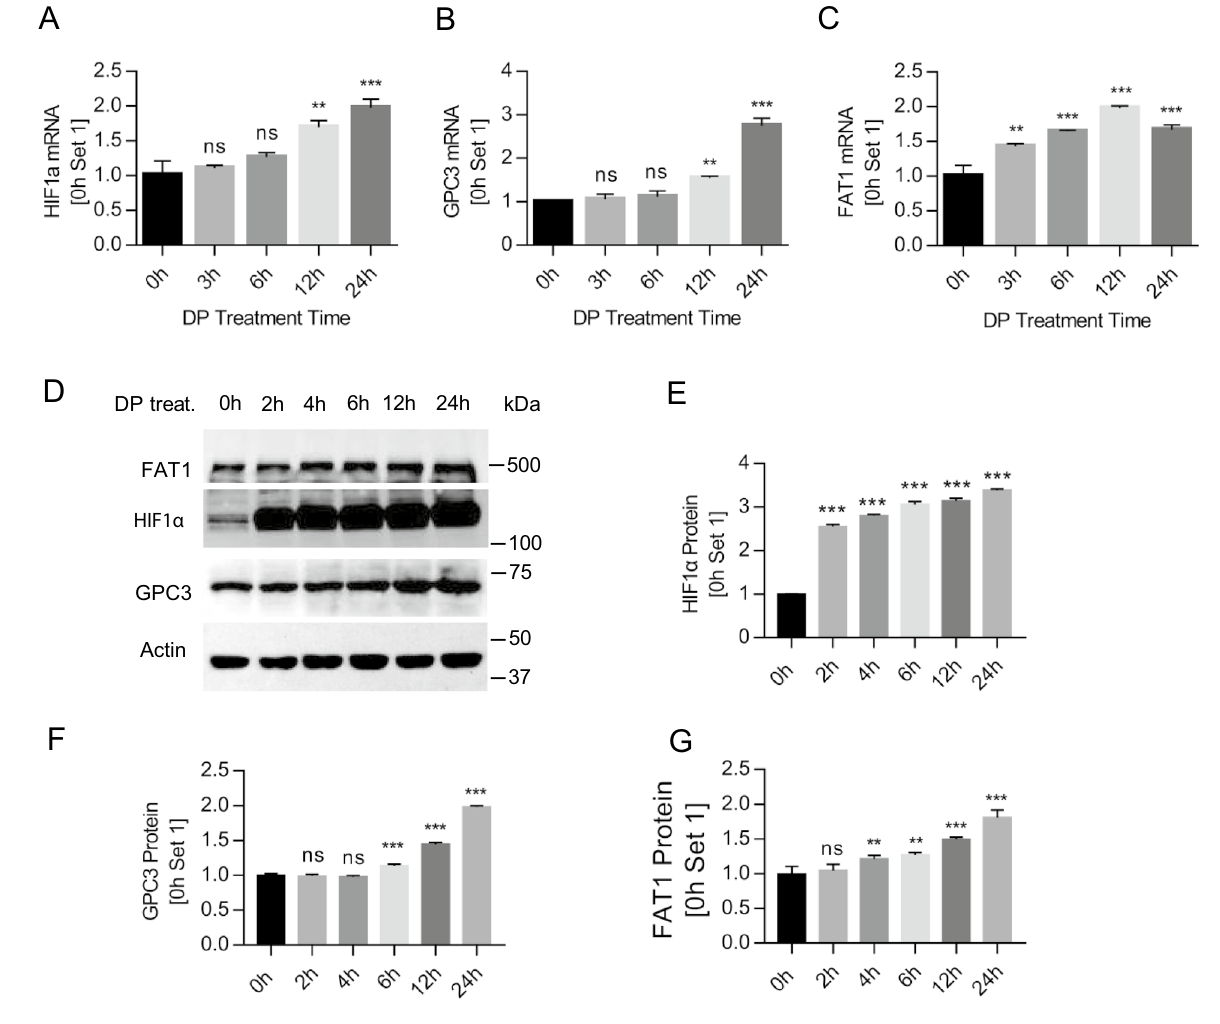
Figure 4. Up-regulated expression of HIF1α, GPC3, and FAT1 under hypoxia. ( A ) HIF1α mRNA level in HepG2 cells after DP (100 µM) treatment for different lengths of time. ( B ) GPC3 and ( C ) FAT1 mRNA levels after same treatment as ( A ). ( D ) Western blot analysis of HIF1α, GPC3, and FAT1 protein levels in HepG2 cells after DP (100 µM) treatment. Full-length blots/gels were presented in Supplementary Figure S4. Quantification was performed based on the band intensity and presented in ( E ) HIF1α, ( F ) GPC3, and ( G ) FAT1. Data represent mean ± SEM (n = 3). ** P < 0.01; *** P < 0.001. ns, not the expression pattern of GPC3 and FAT1 under hypoxia conditions, we treated HepG2 cells with chemical hypoxia inducer 2,2-dipyridyl (DP) as previously described 53 . As shown in Fig. 4, DP treatment significantly up- regulated the expression of HIF1α, GPC3, and FAT1 at both mRNA (Fig. 4A–C) and protein level (Fig. 4D–G). HIF1α protein level responded quickly to hypoxia induction, with an abrupt rising in 2 h of treatment. The up- regulation of GPC3 and FAT1 by DP treatment was apparently lagging behind that of HIF1α. Involvement of GPC3 and FAT1 in HCC cell migration. Metastasis is a major attribute of cancer aggressiveness. In order to clarify the roles of GPC3 and FAT1 in HCC cell migration, we knocked down GPC3 and FAT1 expression by two shRNAs in Hep3B cells, as confirmed by Western blot (Fig. 5A,B). The effect of GPC3 and FAT1 knockdown on cell migration was determined by Transwell assay. Compared with shCtrl, both GPC3 and FAT1 knockdown significantly inhibited cell migration (Fig. 5C,D). GPC3 and FAT1 single knock down had no significant difference in suppressing cell migration, while double knock down had additive effect (Fig. 5E), indicating that the direct association of GPC3 and FAT1 might form a functional complex in suppress- ing migration. PC3 and FAT1 regulated the expression of EMT related genes. To mechanistically understand the interaction of GPC3 and FAT1 in promoting HCC cell migration, we analyzed the regulation pattern of GPC3 and FAT1 on the expression of tumor metastasis-related genes under hypoxic conditions. As shown in Fig. 6,